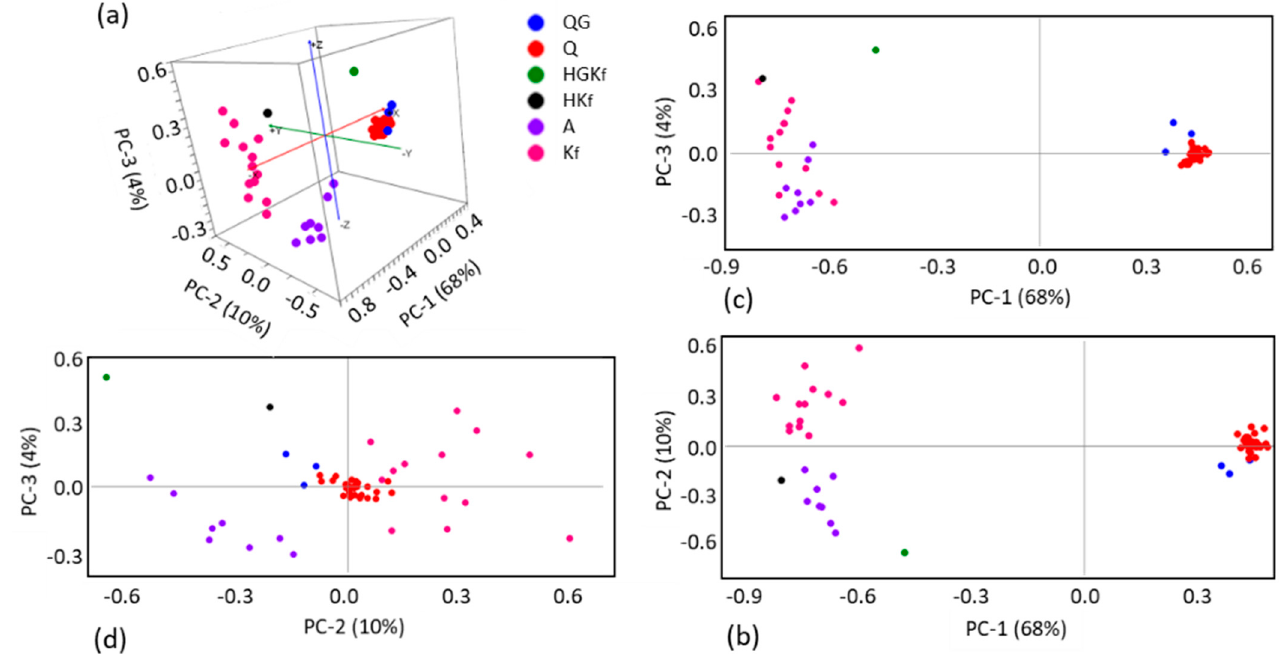
Figure 8. PCA score plots (( a ) PC-3 vs. PC-2 vs. PC-1, ( b ) PC-2 vs. PC-1, ( c ) PC-3 vs. PC-1, ( d ) PC-3 vs. PC-2) resulting from the analysis of the Raman spectra of the shell section of the studied fulgurite. Q: quartz; G: goethite; H: hematite; A: albite; Kf: K-fedspars (microcline and orthoclase).